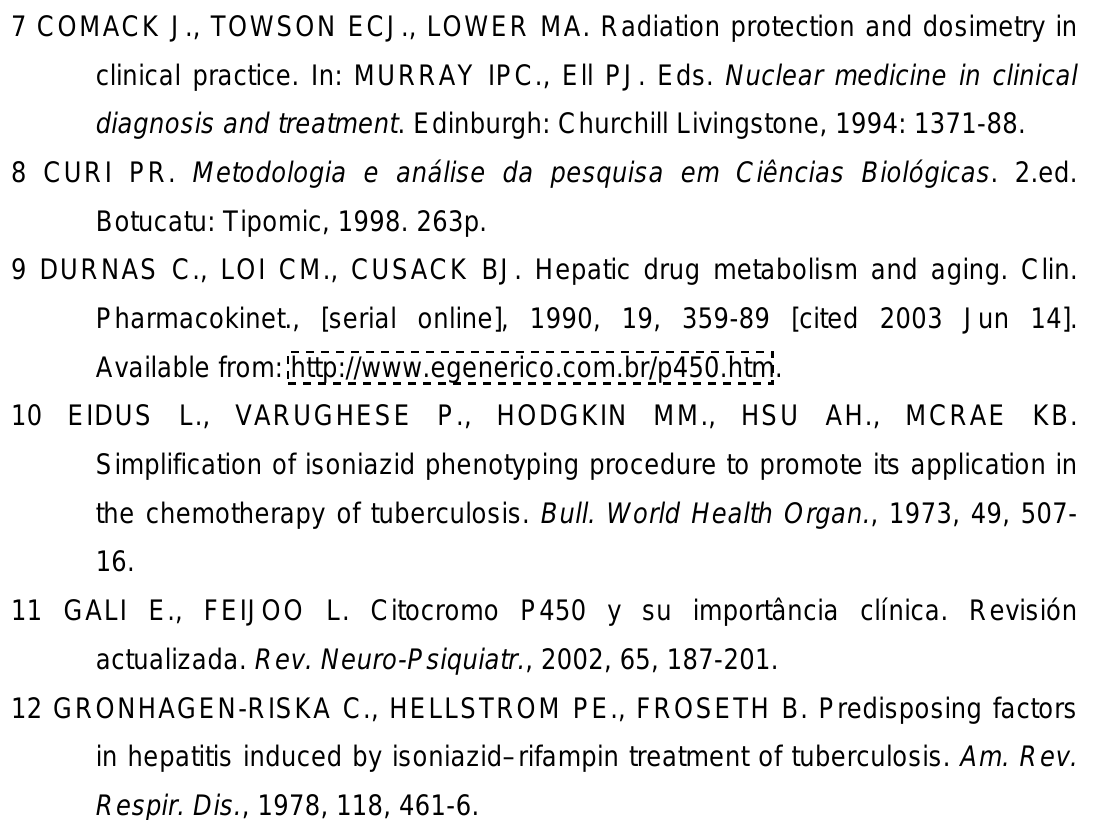
fígado e vias biliares . Rio de Janeiro: Atheneu, 2001: